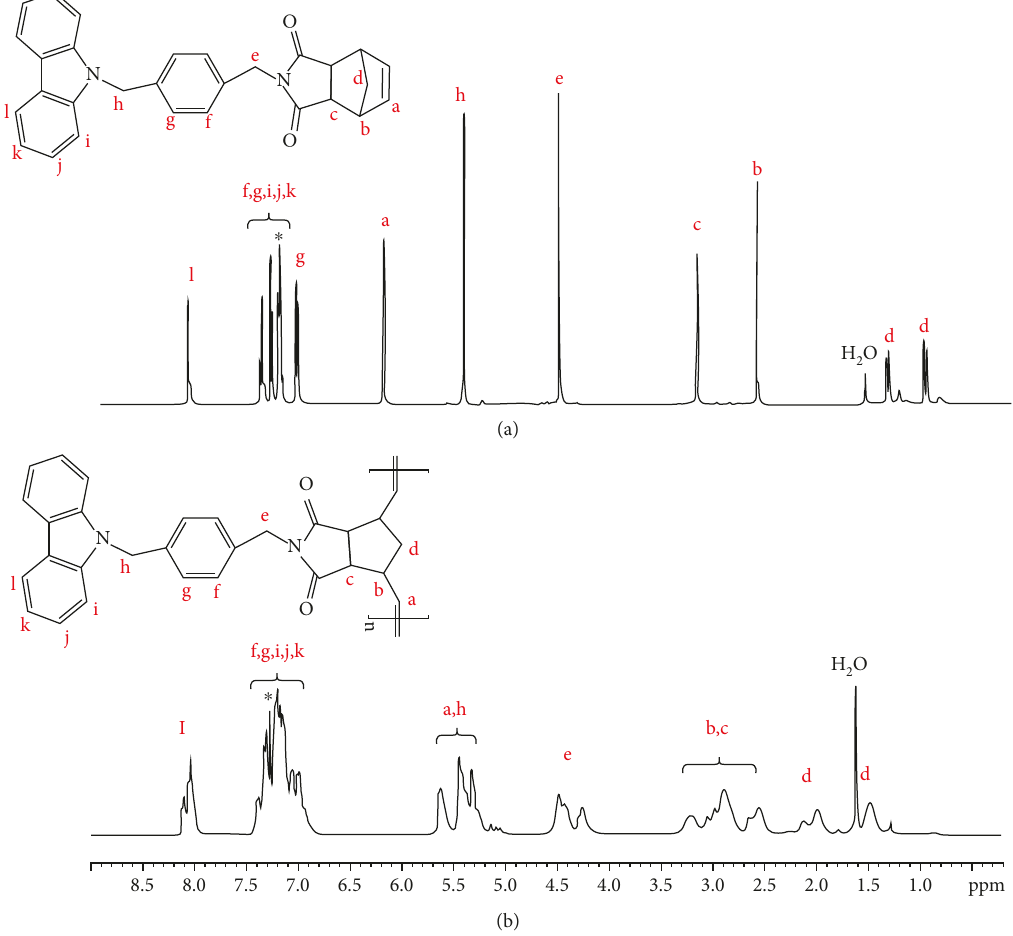
. The residual protio impurity of CDCl 3